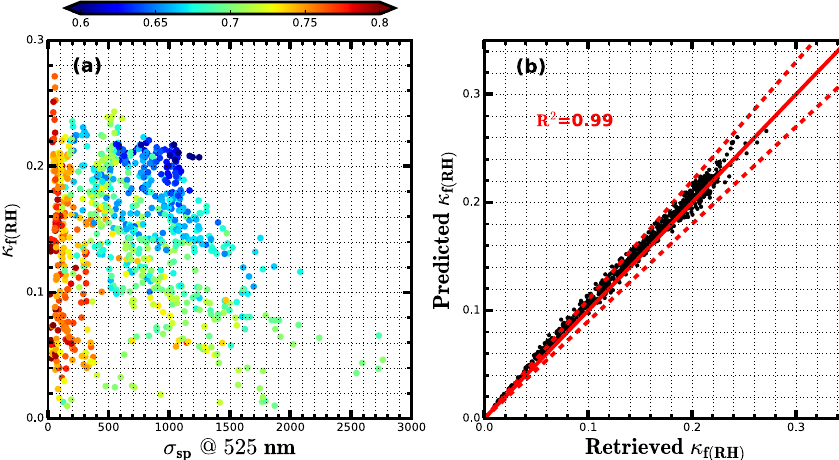
Figure 8. (a) The x axis represents σ sp at 525nm (Mm − 1 ) , the y axis represents retrieved κ f( RH ) , and colors of scatter points represent corresponding values of R κ . (b) The comparison between κ f( RH ) retrieved from Method 1 and predicted κ f( RH ) using the new method. R 2 is the square of the correlation coefficient; the two dashed red lines represent 10% deviations from the 1:1 line.